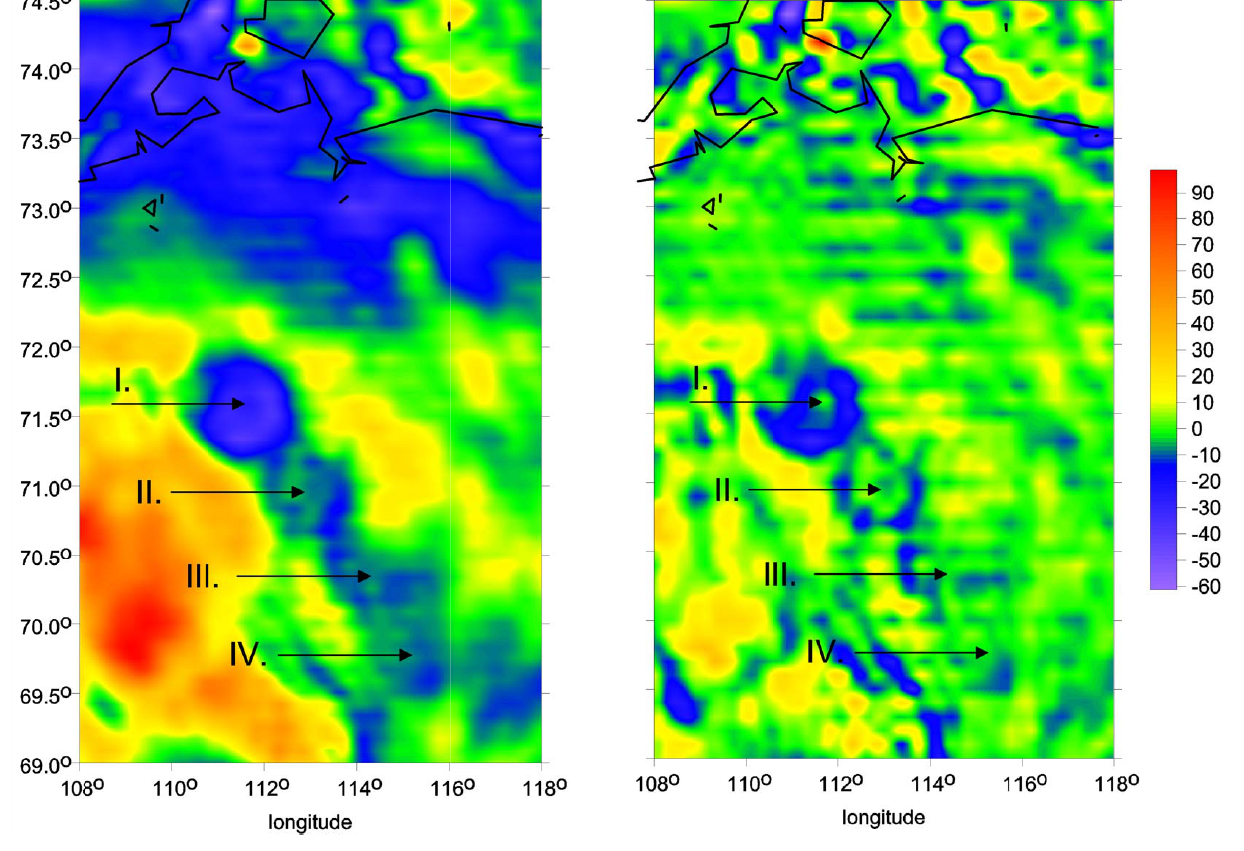
Fig. 2. Gravity anomalies 1g [mGal] computed from the complete EGM2008 at Popigai, Siberia, Russia. Here and everywhere (ex- cluding Figs. 10, 11 and 12) there is a nonlinear scale with green color at zero. The arrows point to Popigai I, II, II (and IV).